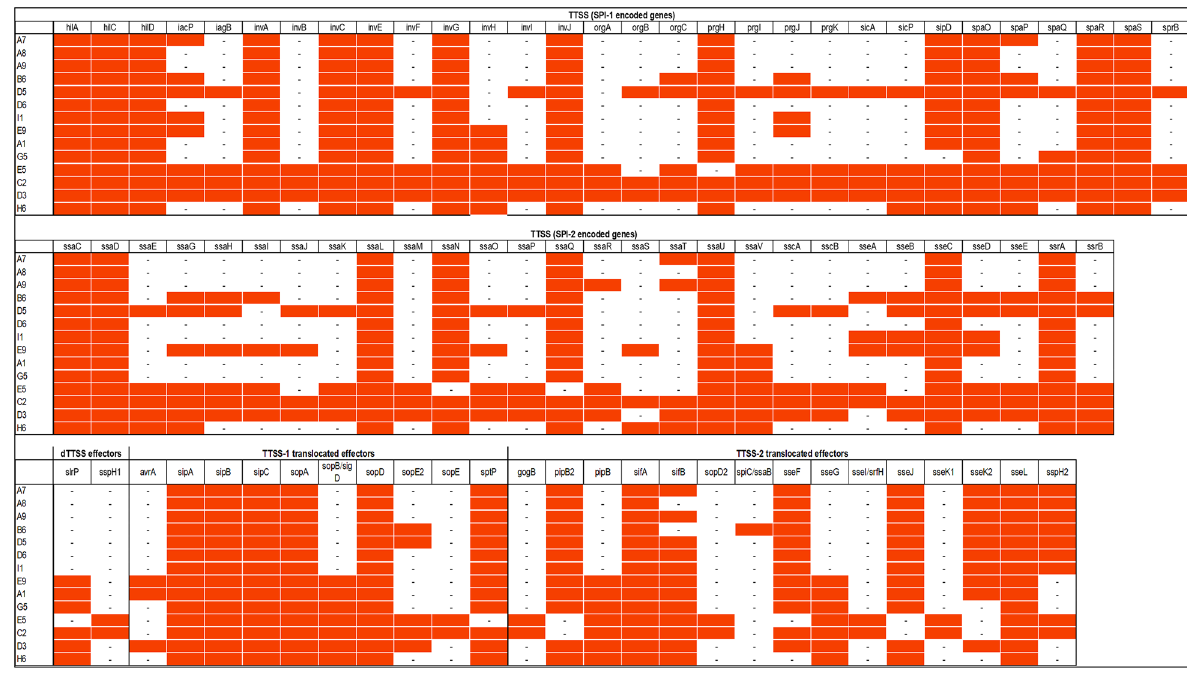
Figure 1. Presence/absence map of genes on SPI1 and SPI2 as well as their translocated effectors. The full red boxes represent presence of the indicated